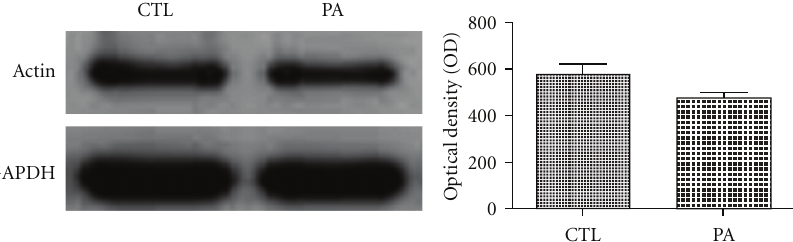
Figure 6: Immunoblots of hippocampal sinaptosomal fractions of 4-month-old CTL and PA rats. We used the glyceraldehyde-3-phosphate dehydrogenase (GAPDH) as loading controls. The assessment of the percentage of optical density of immunoblots from the 4-month-old CTL and PA rats showed no significant di ff erence in the optical density with respect to control group (CTL). P = 0,058. Bars and error bars represent mean +